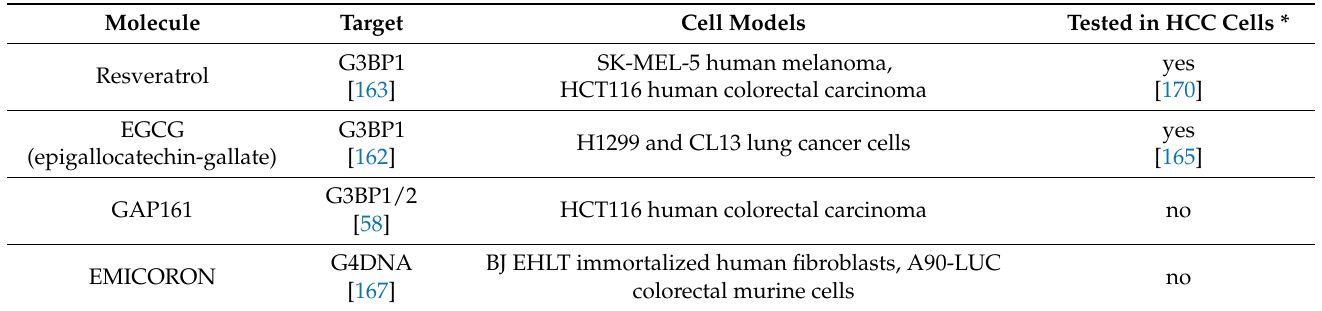
Table 1. Drugs/therapeutics targeting SG components and key regulators of SG